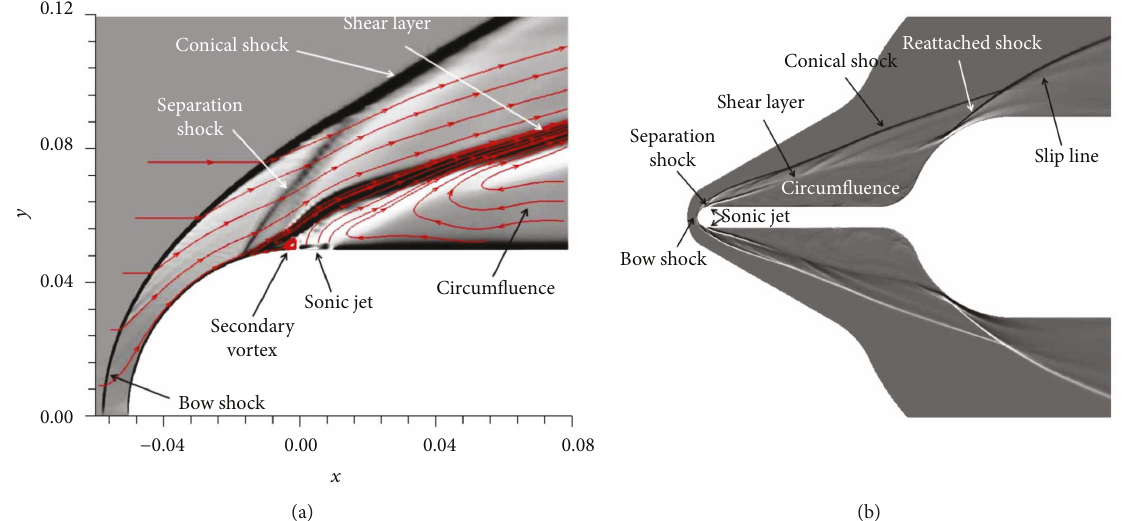
Figure 16: Density gradient in the y direction shows typical fl ow fi eld wave structure around the spiked blunt body (Ma =6.0, L / D =1.0) with sideward sonic jet near the spike nose: (a) fl ow around the spike nose; (b) fl ow around the whole